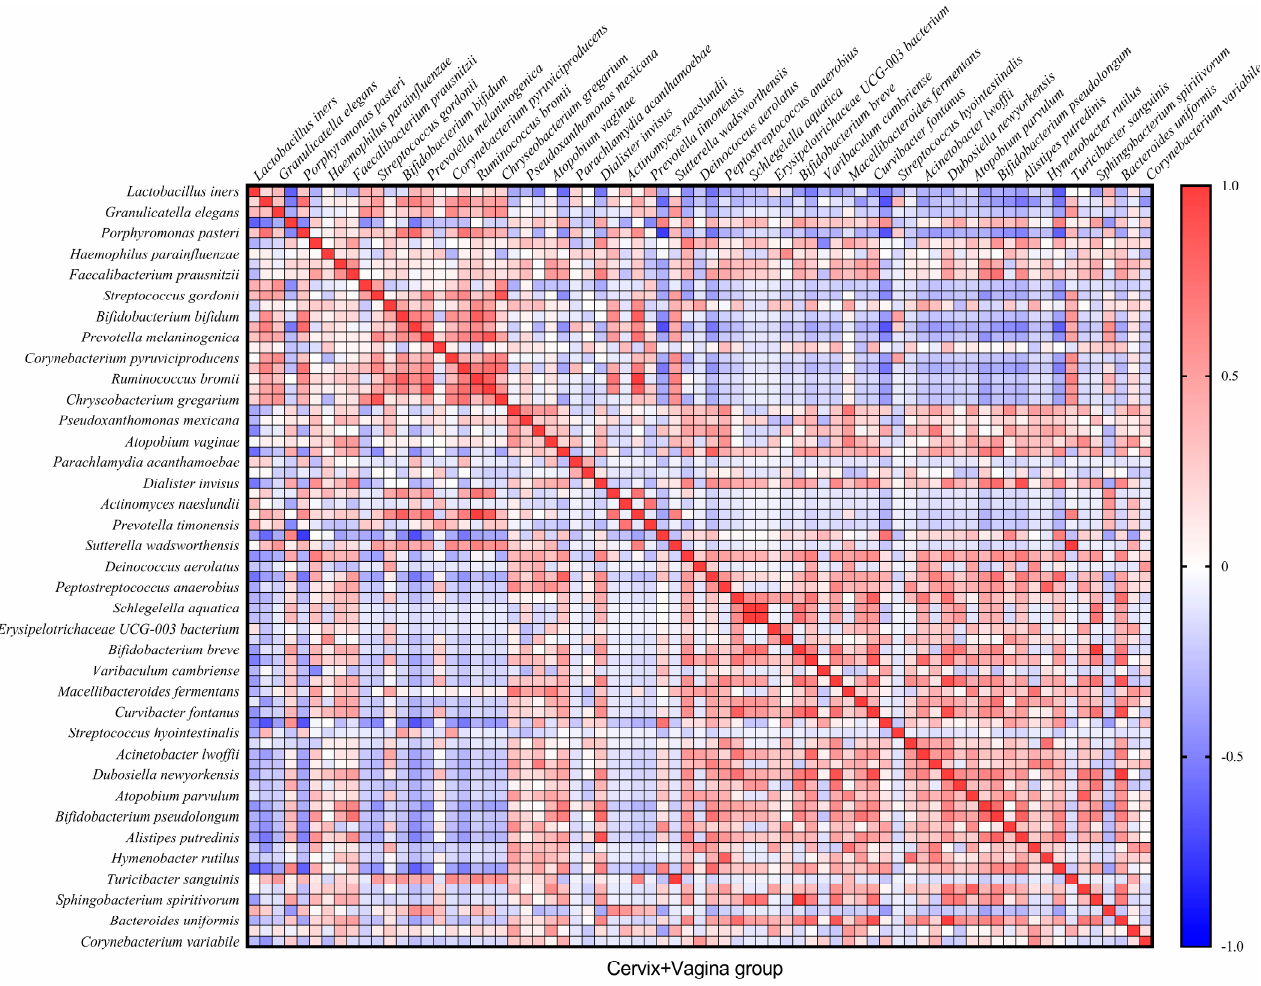
Figure 5. Correlation matrix describing the relationship between microorganisms in the cervical canal + vagina group.